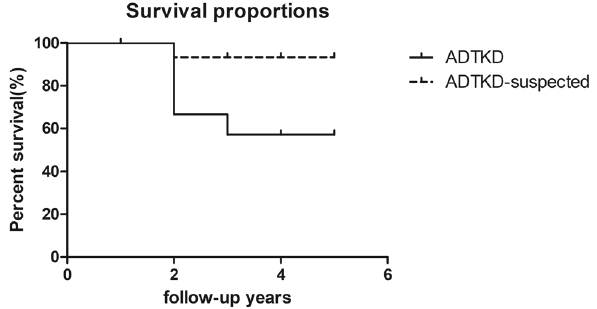
Figure 1. Kaplan–Meier survival analysis of ADTKD and ADTKD-suspected. Renal survival of ADTKD and ADTKD-suspected was investigated by Kaplan–Meier analysis. The longest follow-up time was in the fifth year. Five of 15 ADTKD patients developed ESRD compared to one of 20 ADTKD-suspected (p = 0.029) patients.